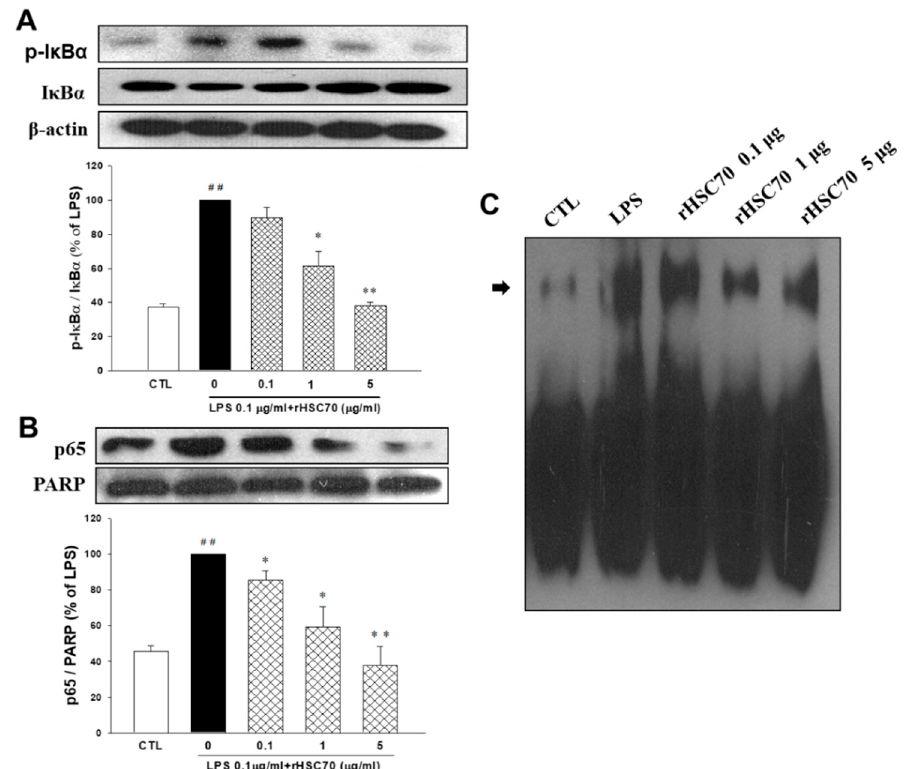
Figure 2. Effects of rHSC70 on LPS-induced phosphorylation of I κ B α ( A ) and NF-kB translocation ( B , C ). Cells were pretreated with rHSC70 (0.1, 1 and 5 µg/mL) for 5 min before LPS treatment and protein samples were prepared 30 min after LPS treatment. ( A ) The cytosolic fractions were used to analyze the content of I κ B α and phosphorylated I κ B α . Western blotting shows that LPS